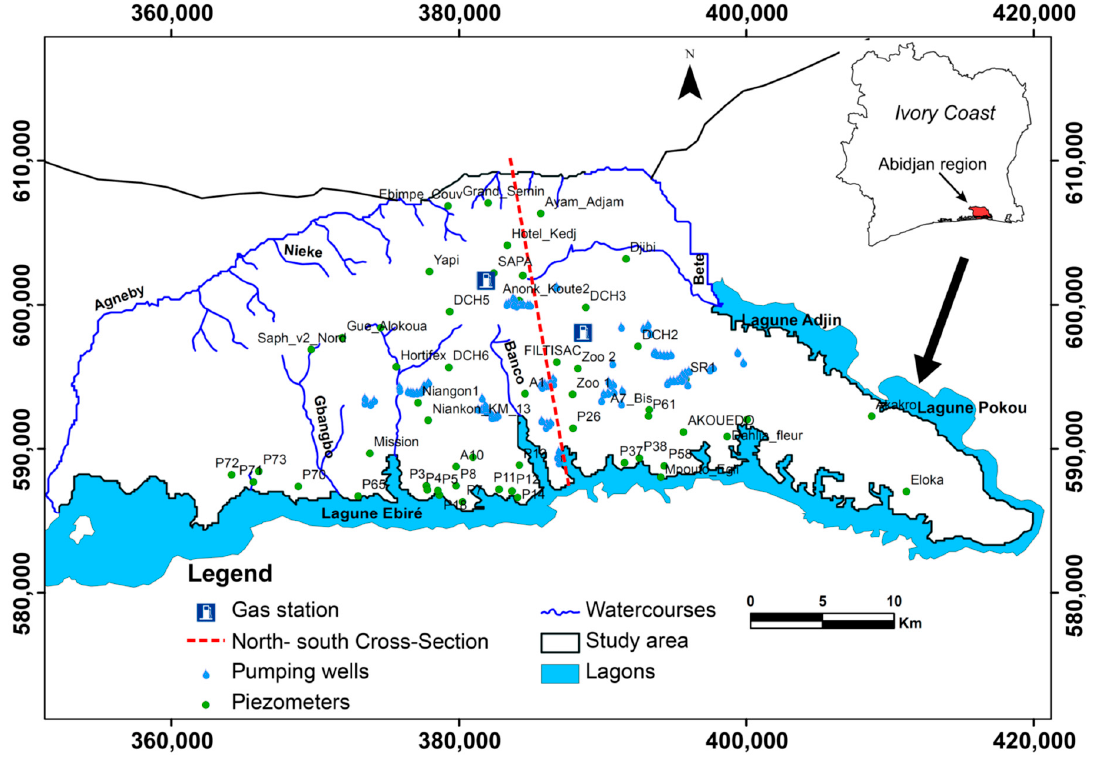
Figure 1. Location of Abidjan District.